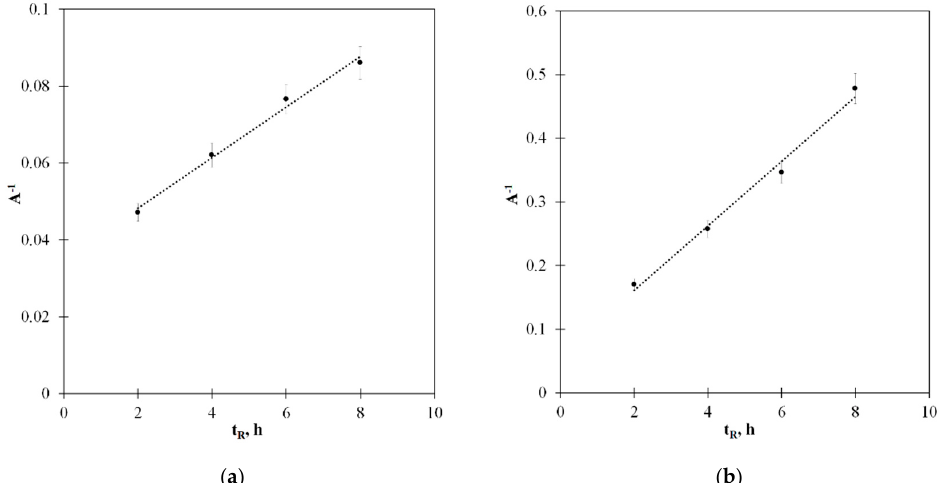
Table 4. Model of H-BEA and H-MFI deactivation at 150°C.